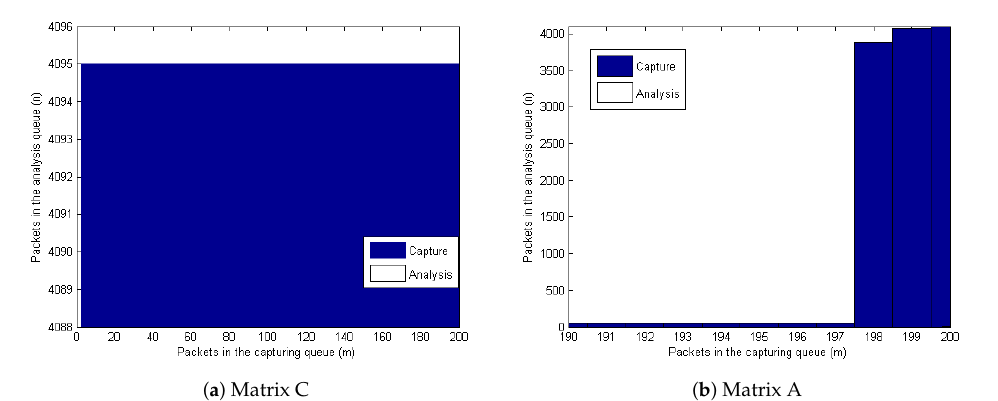
Figure 4. Optimal policy with network traffic rate of 100,000 pps and null analysis